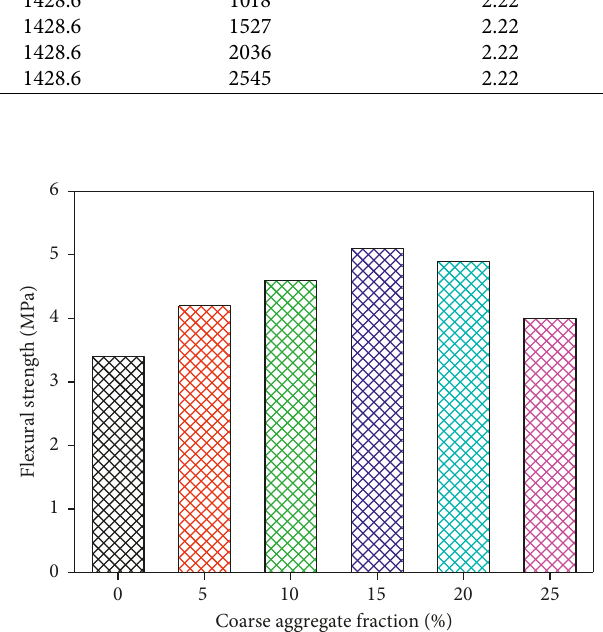
Figure 2: Flexural strength of coarse aggregate interlocking concrete subjected to different increasing amounts of coarse